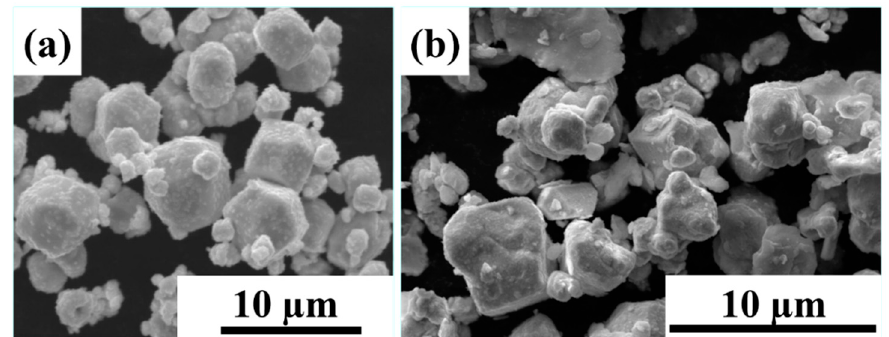
Figure 2. Scanning electron micrograph (SEM) images of ( a ) tungsten (W) particles and ( b ) mechanically alloyed CoCrFeMnNi HEA powder showing the powder morphology.